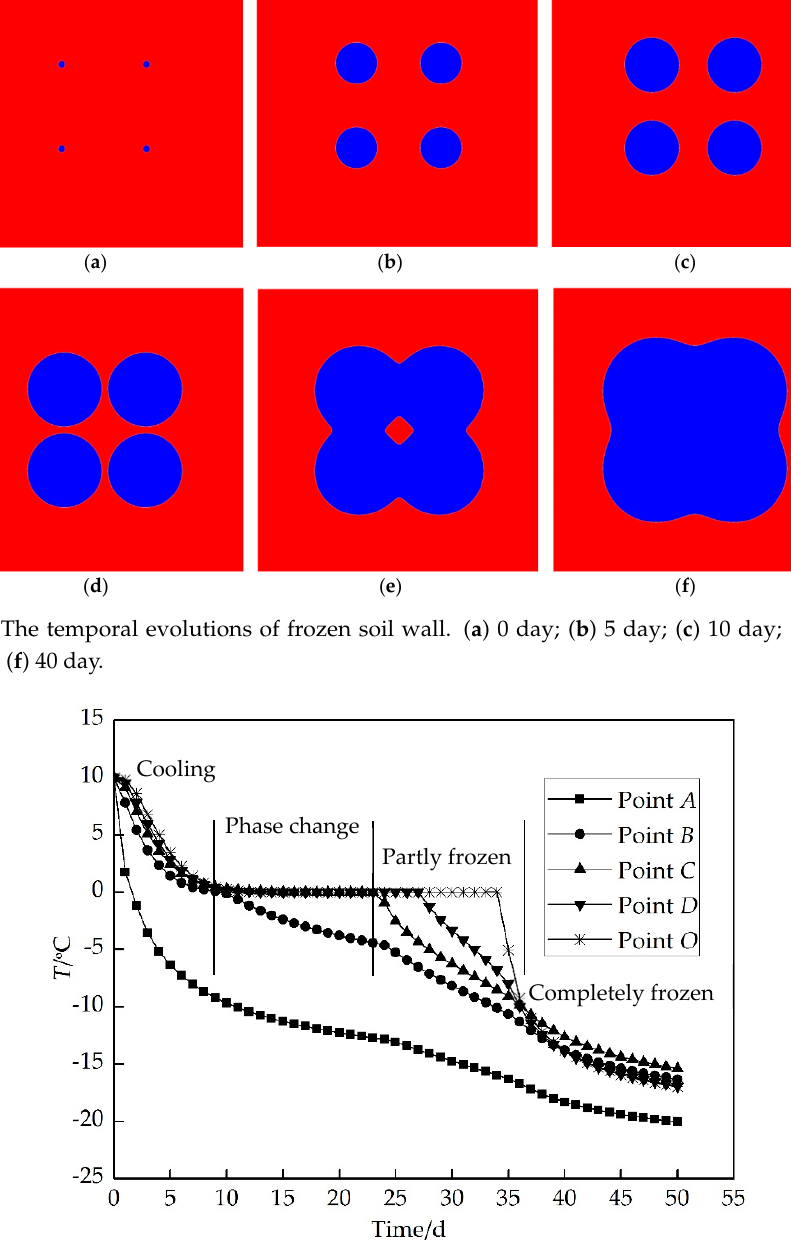
Figure 8. The time–history curves of temperature at the points A , B , C , D and O .